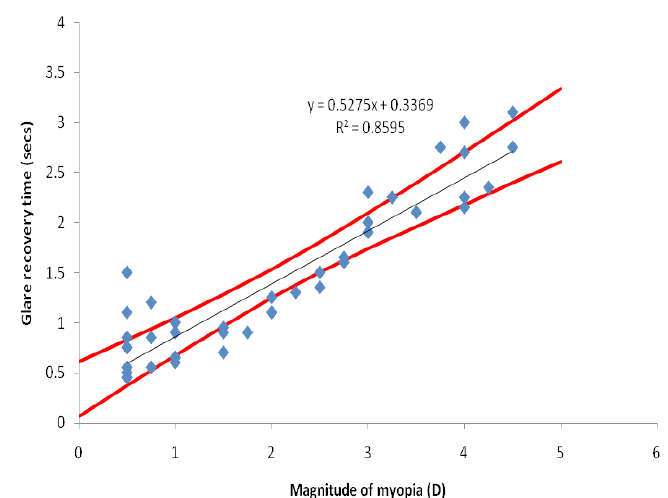
Figure 3: The scatter plots for the glare recovery time plotted against the magnitude of myopia. The solid straight line is the linear regression to the data and the red lines represent the 95% confidence regions. All of the 44 data points are not shown due to the fact that most of the coordinates are the same and the points therefore, lie on each other.